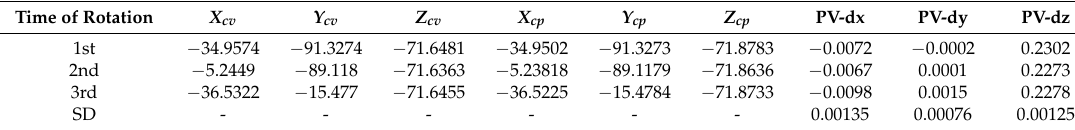
Table 4. Offsets from the VC to the TP (unit: mm).